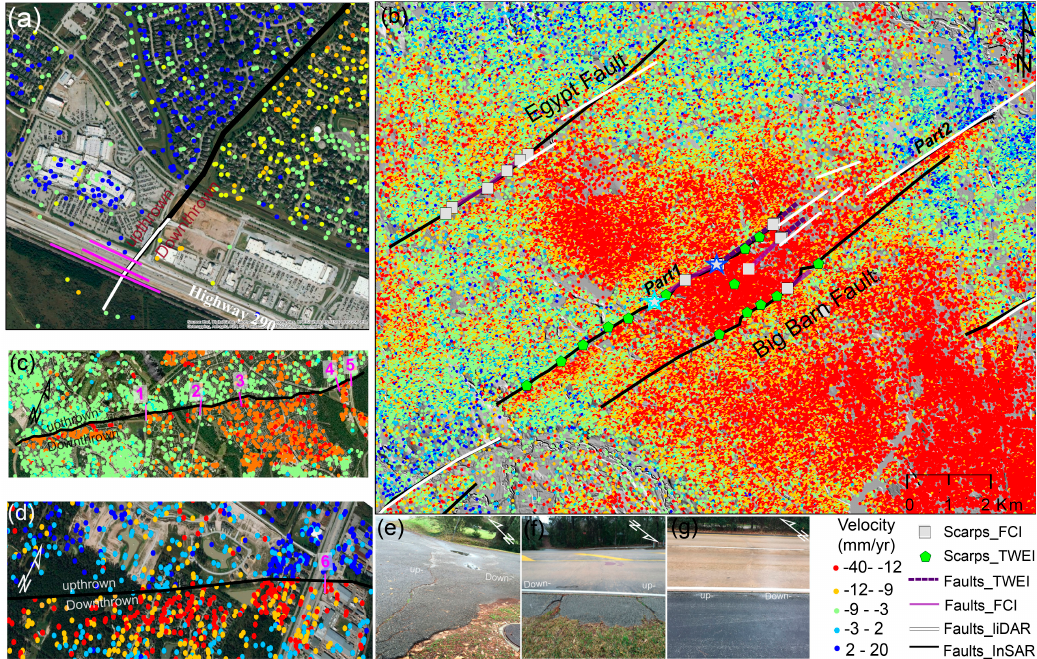
Figure 6. ( a ) Enlarged deformation map of Hockley fault, whose location is shown as a pink star in Figure 5d. ( b ) Enlarged deformation map around Big Barn Fault System, whose location is outlined by the large purple dashed rectangle in Figure 5d. Scarp positions are from FCI and TWEI, and the faults they mapped are based on the scarp locations in the field. ( c , d ) show the enlarged deformation maps of Part 1 and Part 2 (labeled on ( b )) of Big Barn faults, respectively, and the pink lines and numbers display six of the seven field sites of geophysical survey conducted in [37] (the other site is beyond the scope of ( b )). White lines represent the faults mapped by LiDAR [28] , while newly revealed fractures by our MTI processing are in black lines. ( e – g ) show the photos taken in the field investigation, whose locations are marked as colored stars in ( b ) and in Figure 5c (green star for ( e ), light blue star for ( f ) and blue star for ( g )).